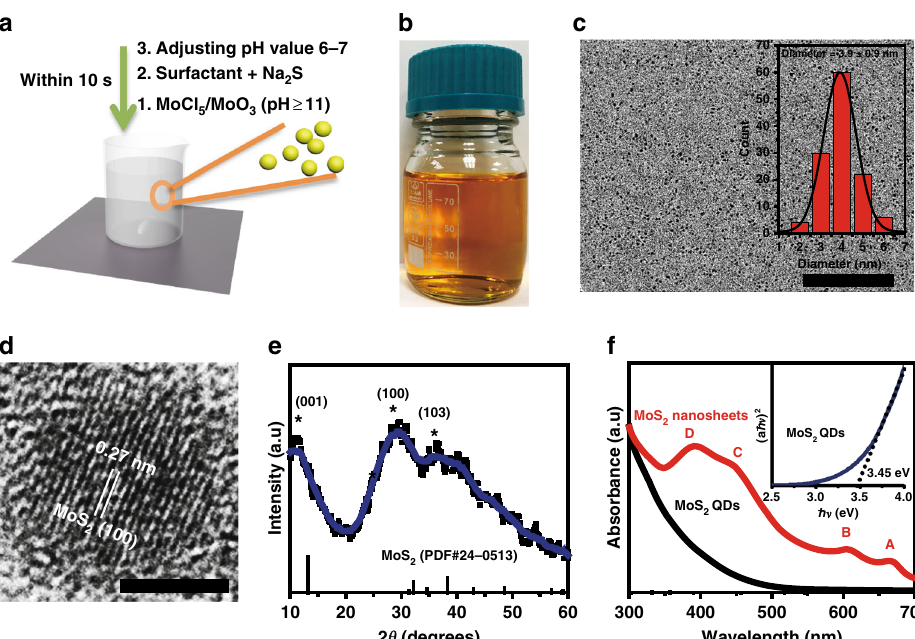
Fig. 1 Benign aqueous room temperature bottom-up synthesis of MoS 2 QDs. a Preparation of MoS 2 QDs with bottom-up strategy. b Easy and scalable aqueous MoS 2 colloidal suspension. Synthesis step takes less than 10 – 20 s (also refer to Supplementary Movie 1). c Ultrasmall but consistent as- synthesized MoS 2 QDs. Inset: Distribution of MoS 2 QDs size measured (ImageJ, n = 200). Scale bar: 100 nm. d HRTEM (Scale bar: 5 nm), e XRD and f UV-vis absorption spectra of MoS 2 QDs showing a distinctively different nanomaterial from exfoliated MoS 2